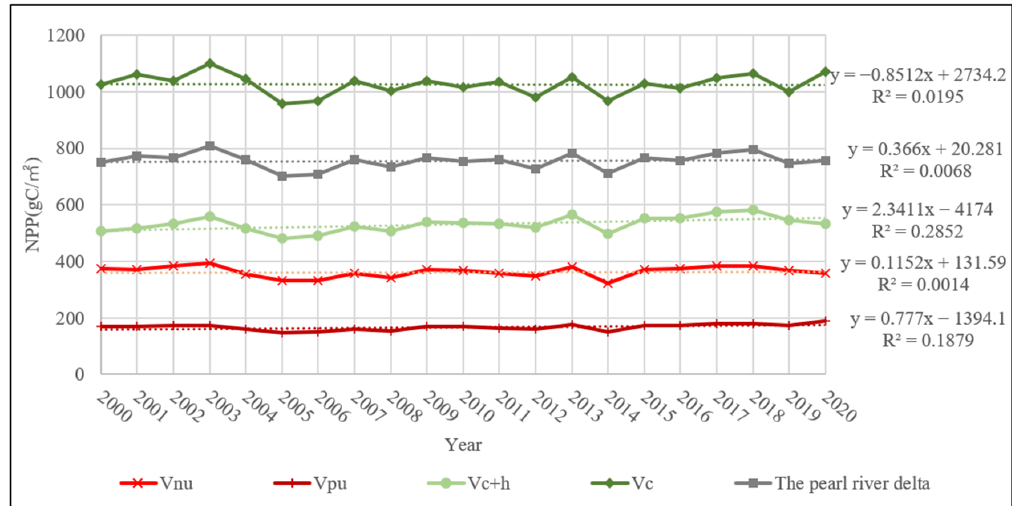
Figure 6. Net primary productivity (NPP) trends of 𝑉 (cid:3030) , 𝑉 (cid:3030)(cid:2878)(cid:3035) , 𝑉 (cid:3041)(cid:3048) , and 𝑉 (cid:3043)(cid:3048) from 2000 to